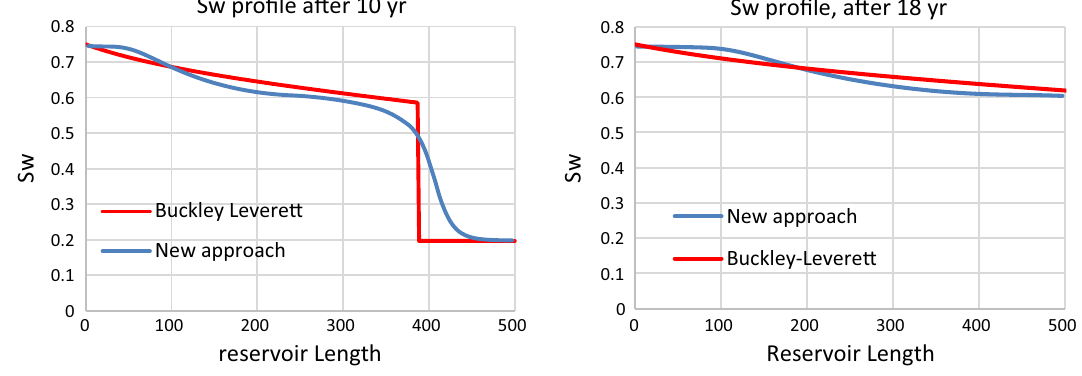
Fig. 13 a Comparison of Sw profile after 10 years for constant flow rate case. b Comparison of Sw profile after 18 years for constant flow rate case